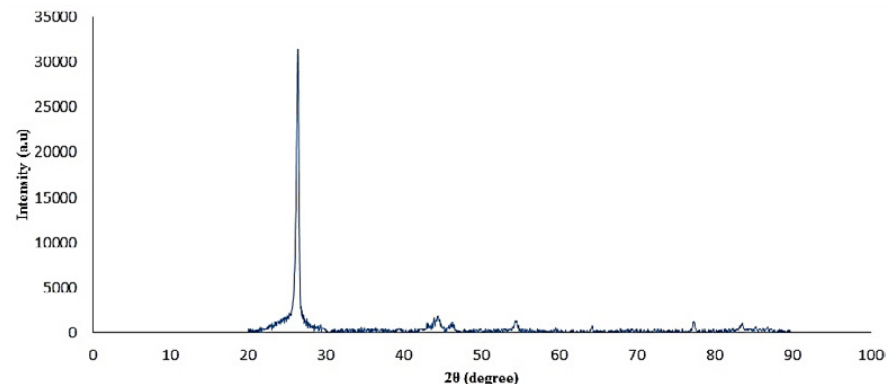
Fig. 3. XRD pattern for CNF